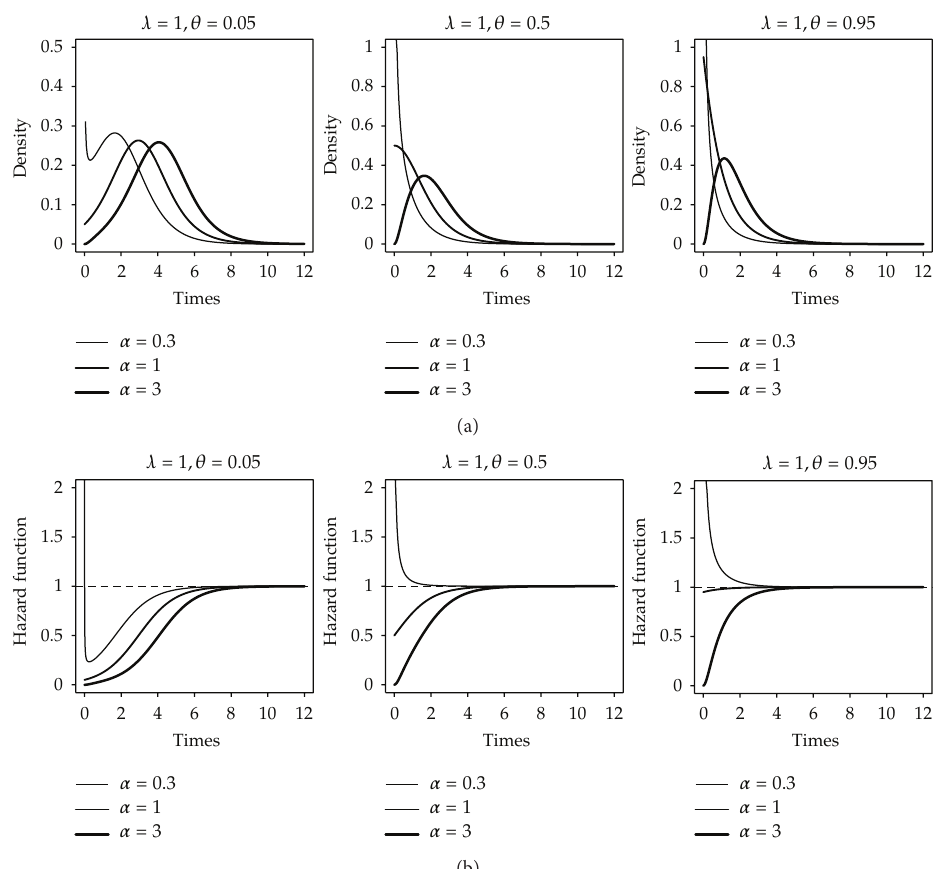
Figure 1: (a) Probability density function of the CE2G distribution. (b) Failure rate function of the CE2G distribution. We fixed 𝜆 = 1 .